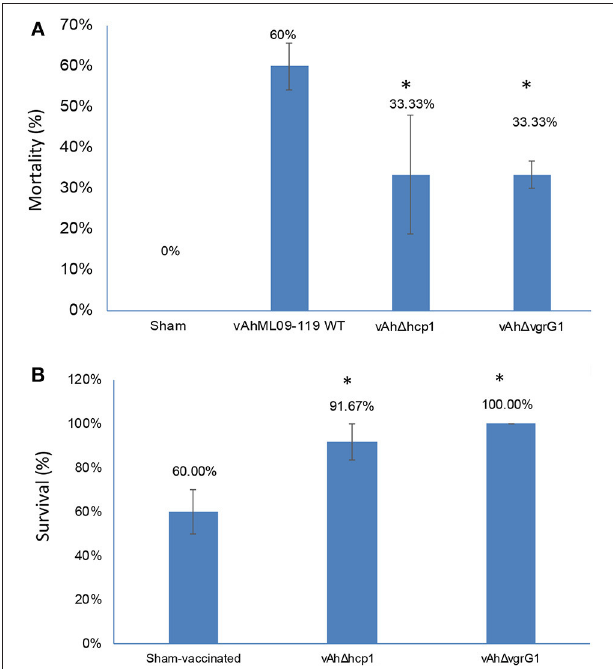
FIGURE 3 | Virulence of vAh T6SS mutants in channel catfish fingerlings. (A) Percent mortalities in catfish fingerlings experimentally infected with vAh T6SS mutants and vAh wild type (WT) strain ML09-119. (B) Percent survival in catfish fingerlings surviving infection with T6SS mutants and re-challenged with vAh WT at 21 d post-infection. Data are the mean ± SE of three replicate tanks. Significant differences between challenged and non-vaccinated treatments are indicated with asterisks ( p <